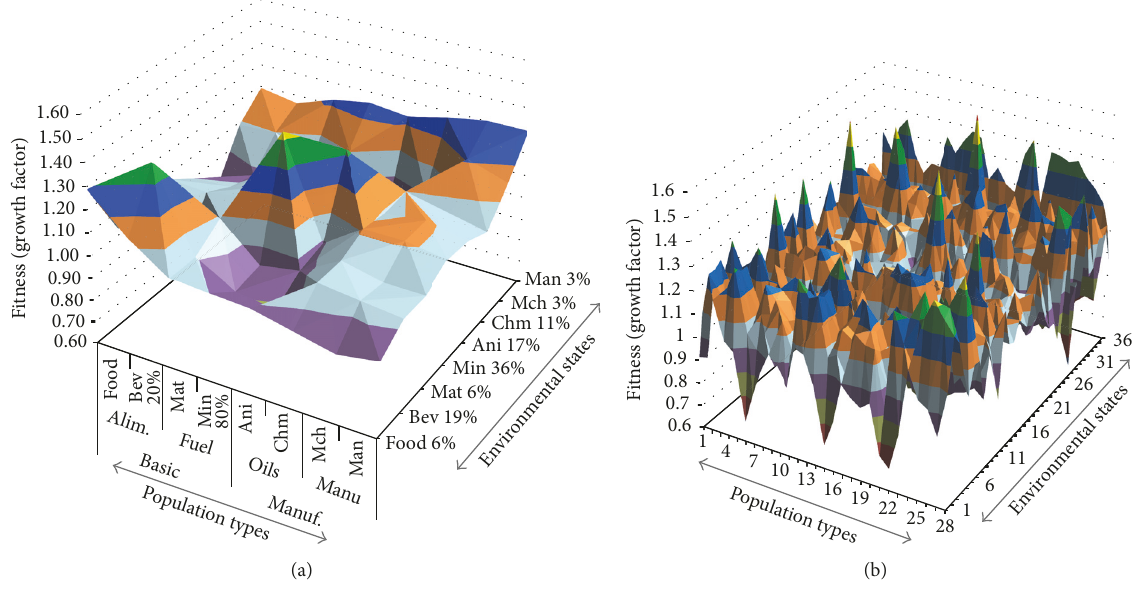
Figure 1: Fitness landscape where the bottom dimension refers to different population types (groups of the overall population) and environmentalstates(temporalperiods),whiletheheightrepresentsfitness(thegrowthrateofeachtypeineachstate,followingthetraditional definition of fitness in fitness landscapes ( 28 )). Both (a) and (b) represent the same case, while (a) is coarse-grained into 8 population types and 8 environmental states; and (b) is fine-grained into 28 population types and 36 environmental states (based on data from